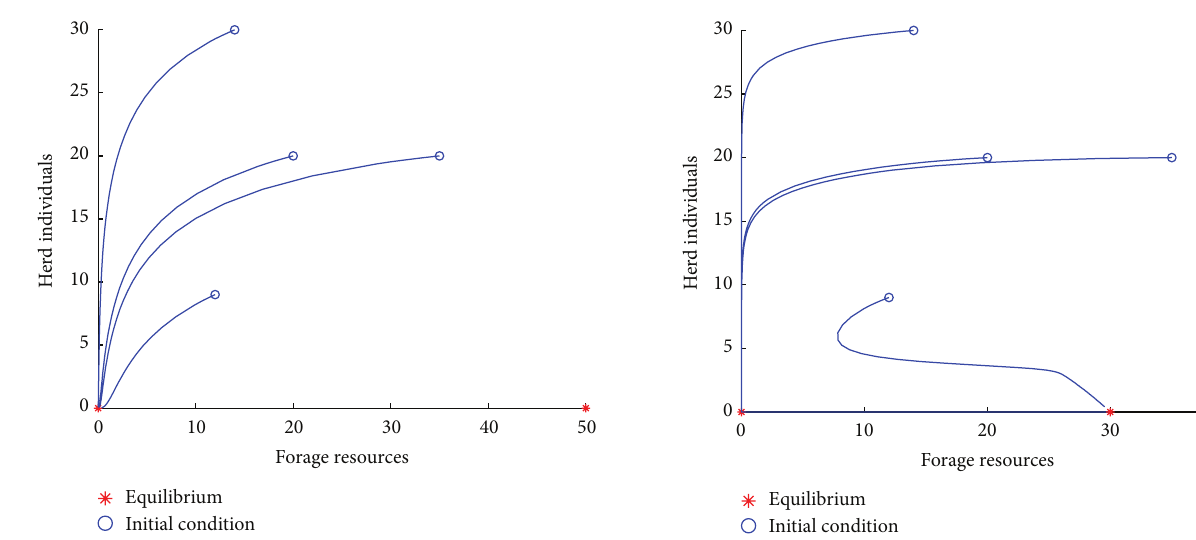
Figure 1: Phase portrait of the herd’s animals and forage resources when r < 0. This illustrates the global stability of equilibrium 𝐸 0 = (0,0) for System (1). This is a new situation, which happens during migration of pastoralists with their herds, calling transhumance; the pastoralistsleave thearea because of scarcity of forage resources. The parameters in this case are given in Table 1.